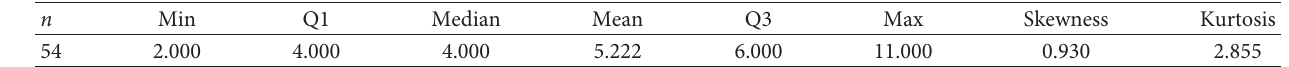
Table 5: Descriptive statistics for first data.